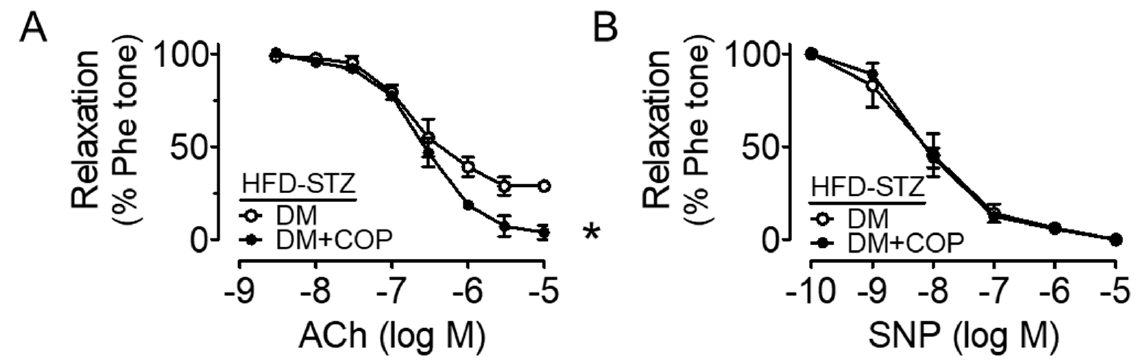
Figure 3. Coptisine (COP) protects endothelial function in diabetic mice. ( A ) Diabetic mouse model was induced by high fat diet (45% kcal% fat) and i.p. injection of streptozotocin (120 mg/kg) (HFD-STZ) and ex vivo treatment of COP (1 µM, 16 h) improved Ach-induced relaxations in diabetic (DM) mouse aortas. ( B ) SNP-induced relaxations were unaffected. Results are the mean ± SEM of 3 experiments. * p < 0.05 vs.